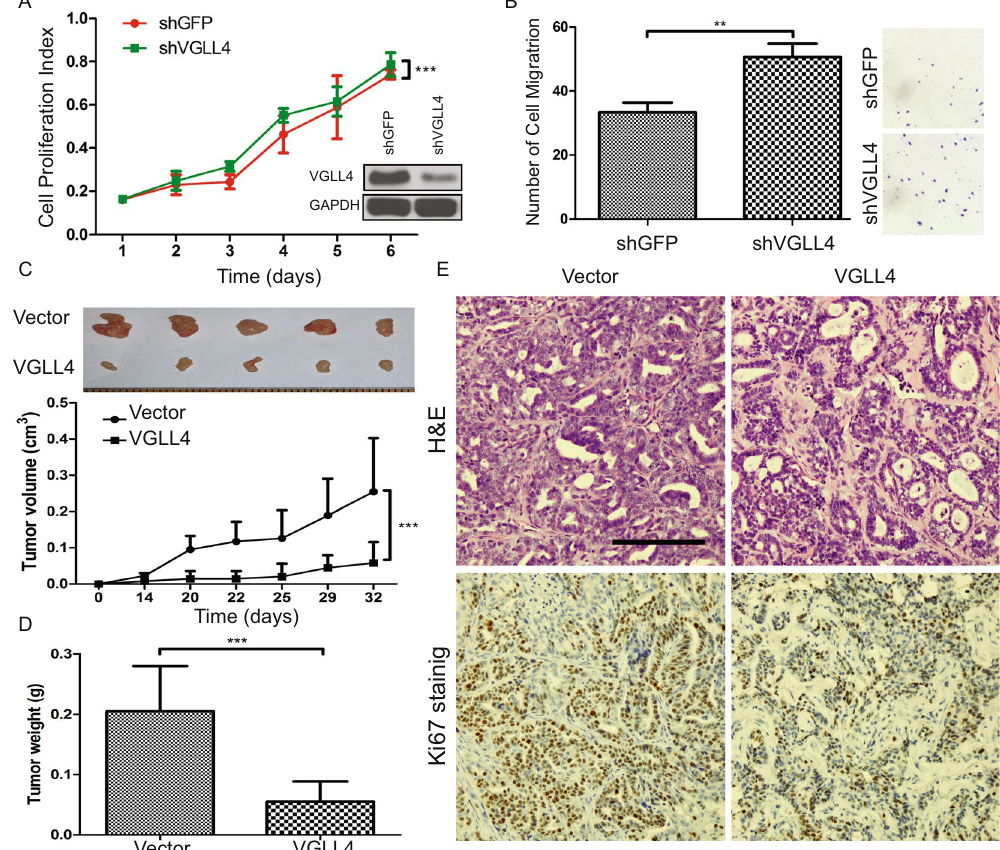
Figure 3. Knockdown of VGLL4 promotes cell proliferation and VGLL4 overexpression suppresses breast tumor growth in vivo . ( A ) Cell proliferation by the MTT assay for shGFP- or shVGLL4-transduced T47D cells (inset: VGLL4 knockdown efficiency demonstrated by immunoblot). ( B ) Migration images and quantification of T47D cell transduced with shGFP or shVGLL4. Overexpression of VGLL4 in CAL-51 cells dramatically reduces the tumor growth potential ( C ) (top panel: representative tumor images), tumor weight ( D ). ( E ) H&E and Ki67 immunohistochemistry (IHC) staining of xenograft tumors. (Scale bar = 100 µ m) ( ** P < 0.01, *** P <